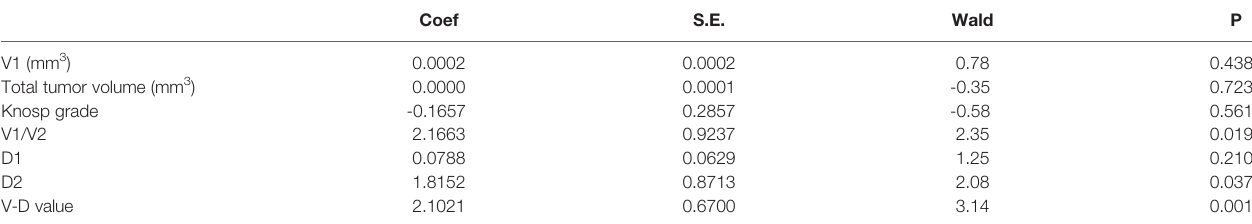
TABLE 4 | Multivariate Logistic regression between recurrence and multiple factors.